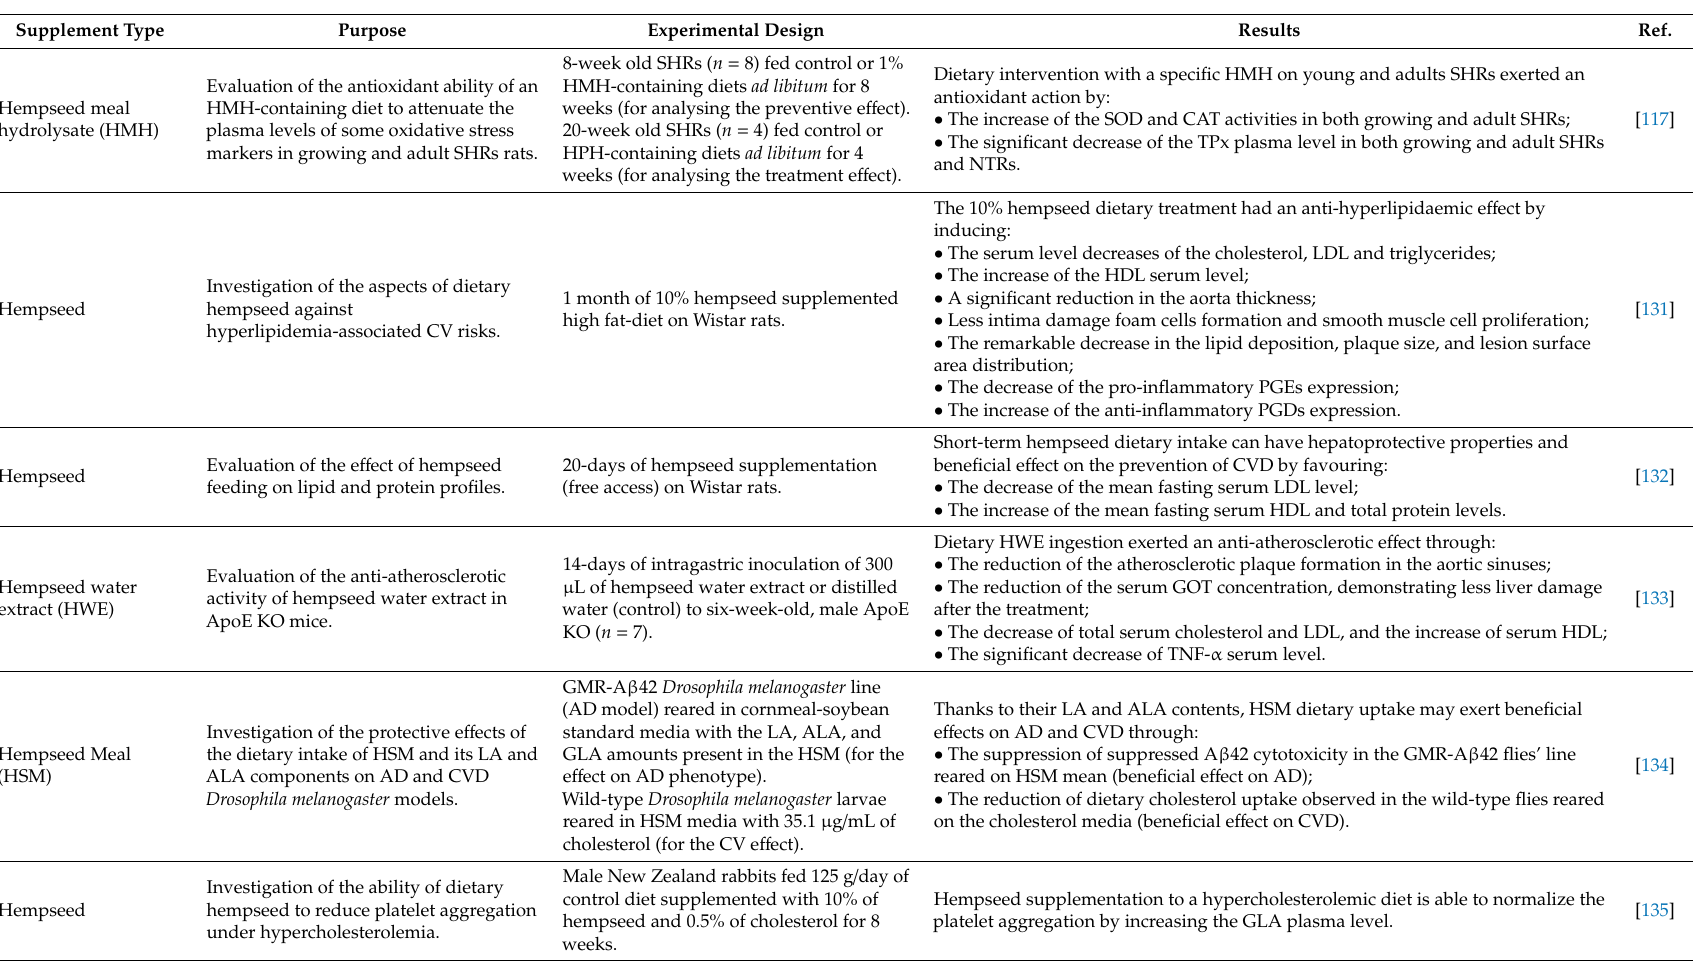
Table 11. Literature studies on the e ff ect of hempseed or hempseed products’ dietary supplementation on animal